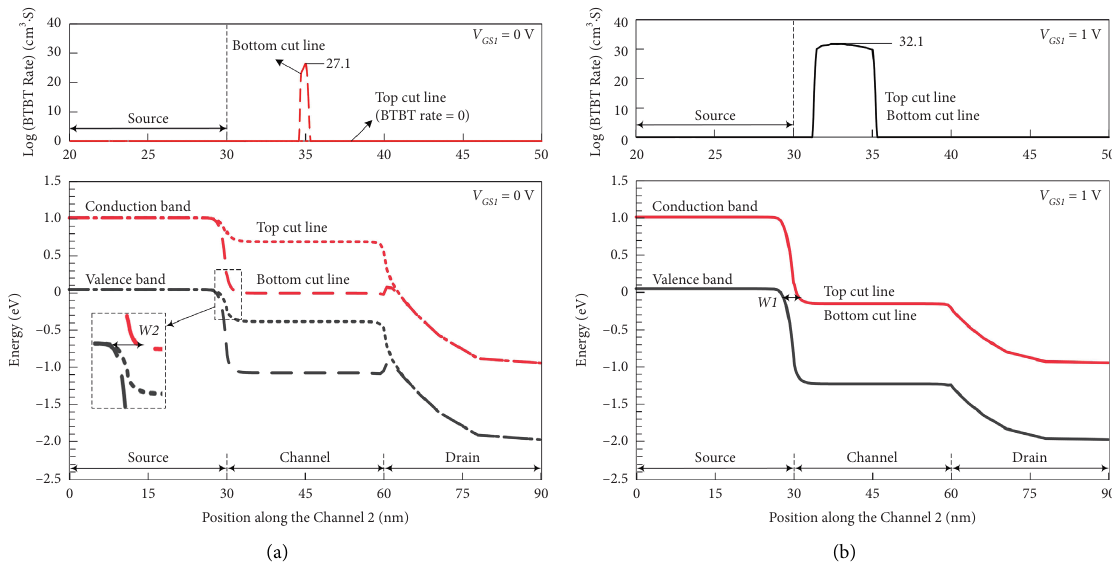
Figure 5: V � 1V and V � 0V, energy band distribution and BTBT rate along top and bottom cut lines shown in Figure 1(a) in GS3 GS2 different switching states, (a) V GS1 � 0 V and (b) V GS1 � 1V, the inset is an enlarged view of the energy band distribution at the interface between source and channel.